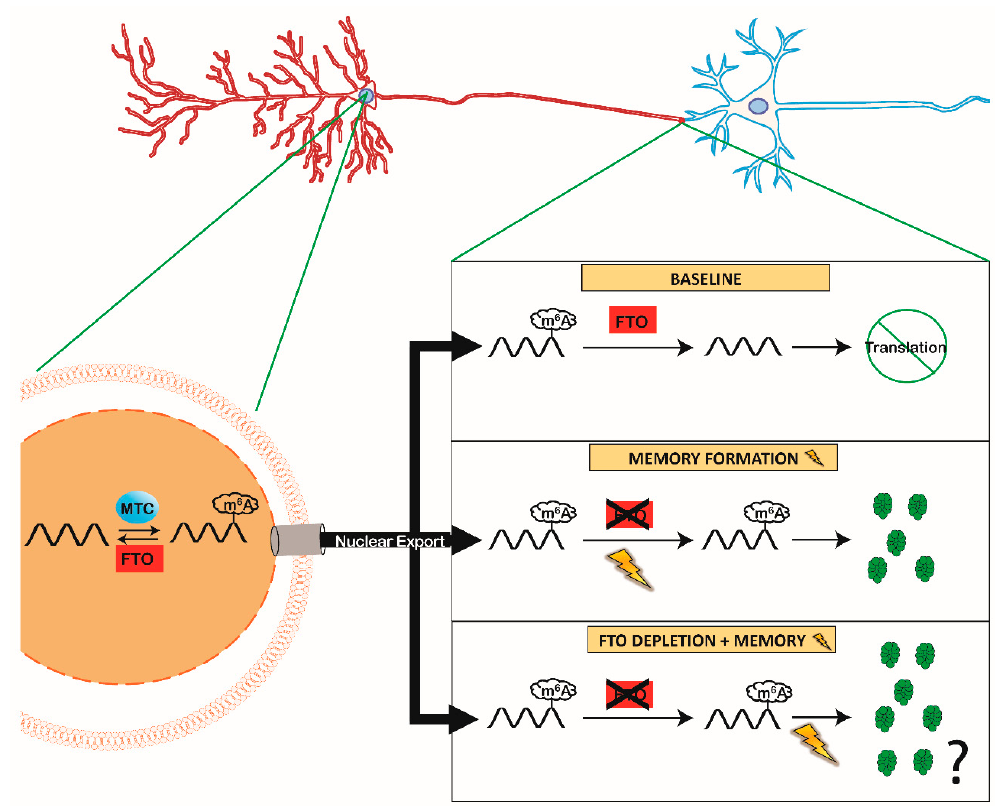
Figure 1. The Role of Synaptic Fat Mass and Obesity-associated (FTO) During Memory Formation. MTC members (METTL3 and METTL14) and FTO are localized within the nucleus (left) to dynamically add and remove m6A in mRNA, respectively. Under baseline conditions, this creates a competition between the methylated or demethylated status of mRNA that is shipped from the nucleus to the synapse. However, FTO is also present in the synaptic compartment [11,15,19], right) removing m6A from mRNA at baseline conditions, preventing mRNA translation. During memory formation (lightning bolt) synaptic FTO is removed inhibiting demethylation in the synaptic compartment (right middle). Resulting in a preserved m6A tag in mRNA localized at the synapse and leading to rapid translation during memory formation. Experimental evidence has shown improvement in memory when FTO is depleted ([15,56,58] right bottom), we propose that early FTO depletion increases the amount of translated pro-memory proteins in response to memory.